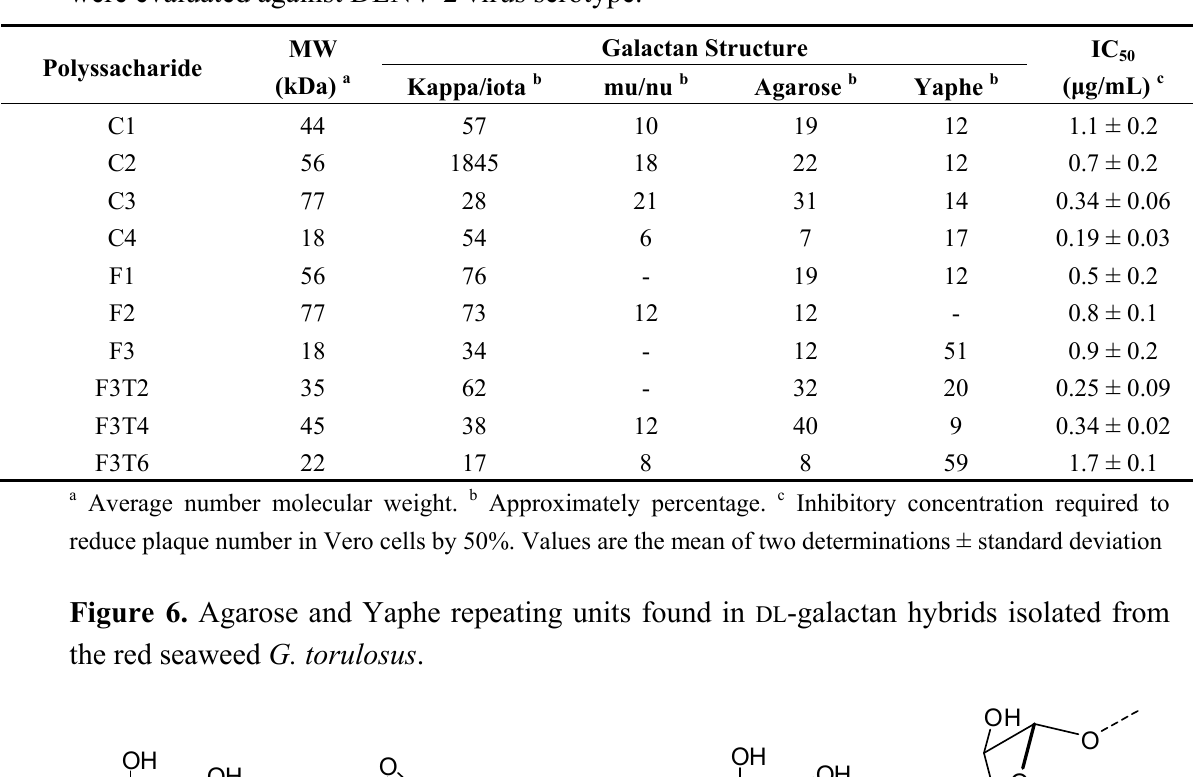
were evaluated against DENV-2 virus serotype.